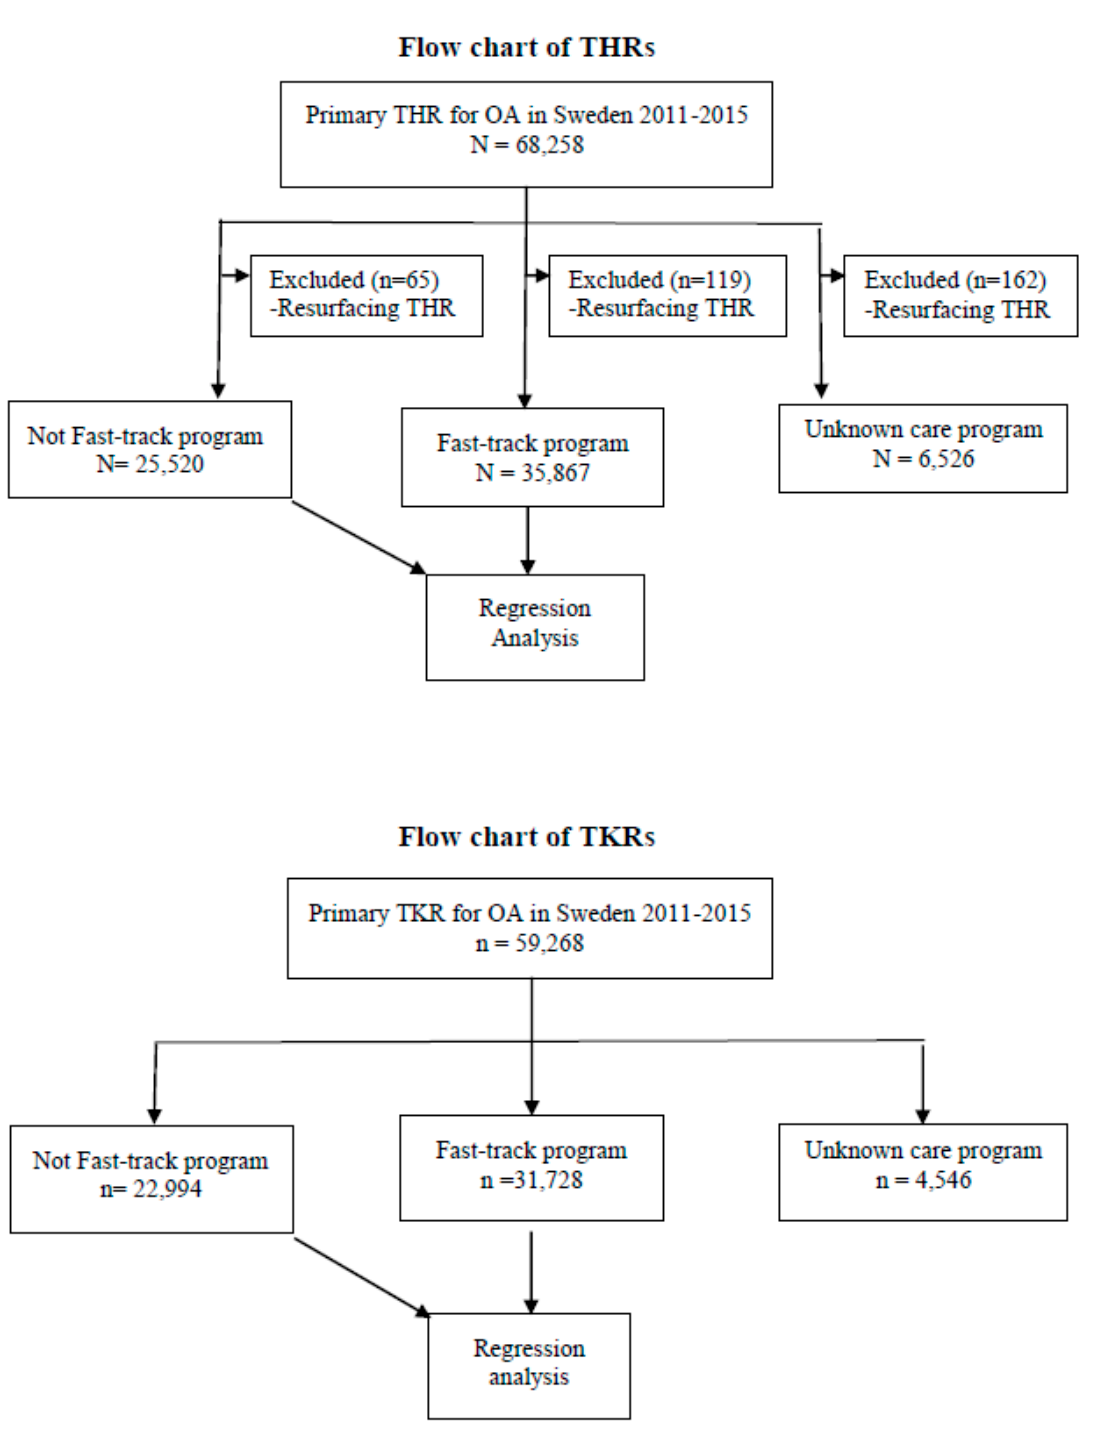
Figure 1. Flow chart of the study. (THR = Total Hip Replacement; TKR = Total Knee Replacement; OA = Osteoarthritis; n = Number of operations).